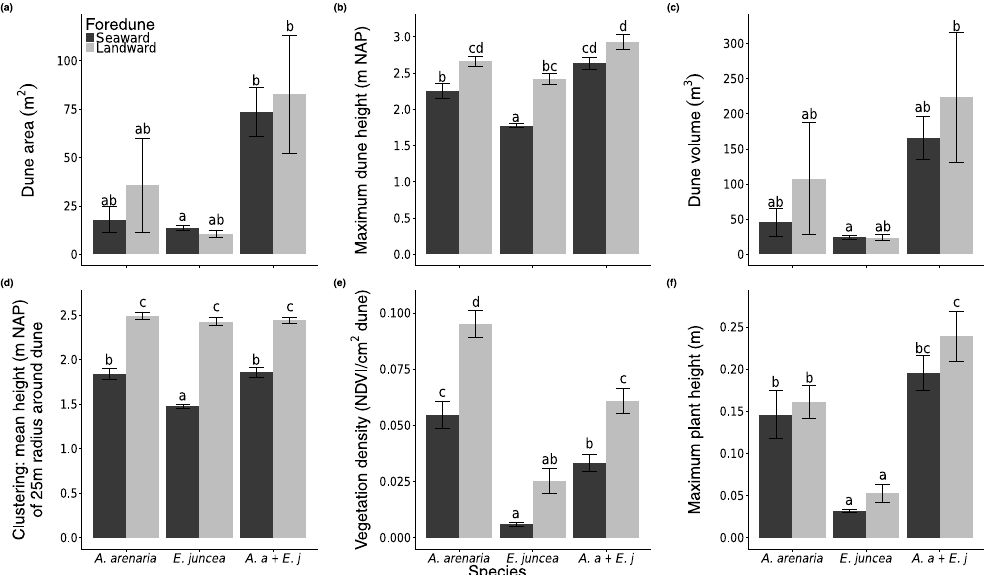
Figure 4. Different dune characteristics for nebkha dunes in August with A. arenaria , E. juncea and a mix of both species separated for dunes seaward and landward of the foredune: (a) dune area, (b) maximum dune height, (c) dune volume, (d) clustering: mean height around a 25m radius around the dune, (e) vegetation density, (f) plant height. The letters denote the significant difference between the bars. Seaward of the foredune there were 41 dunes with A. arenaria , 193 dunes with E. juncea and 53 dunes with both species. Landward of the foredune there were 81 dunes with A. arenaria , 23 dunes with E. juncea and 41 dunes with both species. NAP refers to Amsterdam Ordnance Date, which refers to mean sea level near